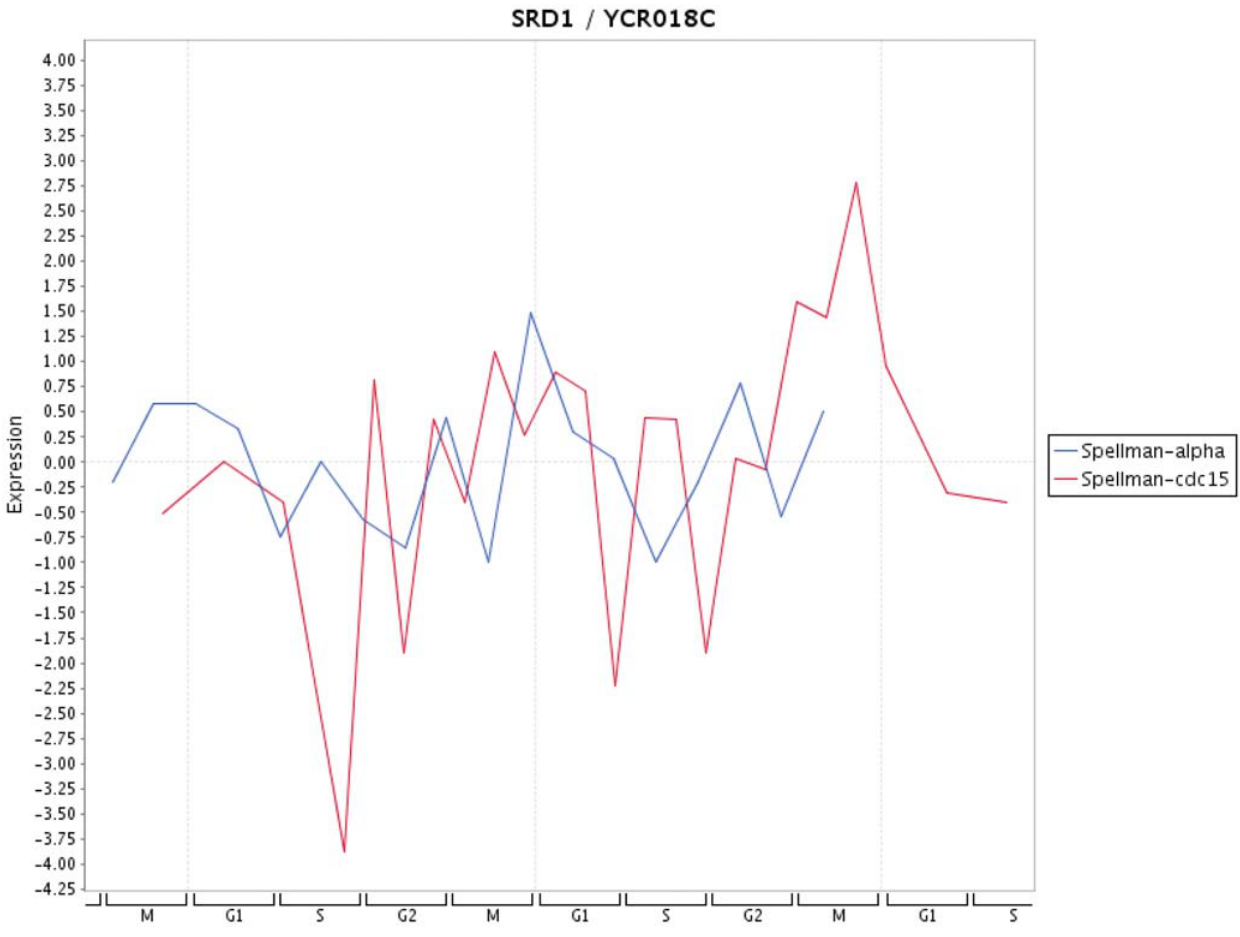
Figure 11. Expression profile for SRD1 for time series data from S PELLMAN et al. [ 32 ] .